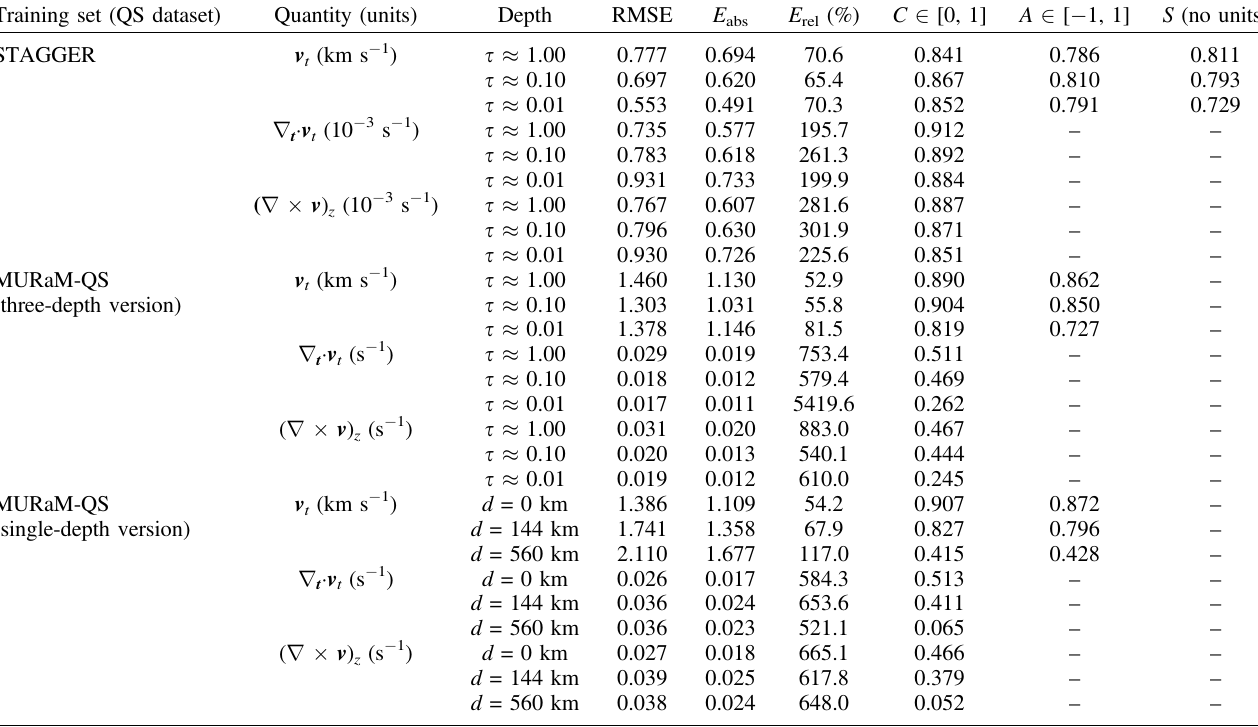
Table 2. Comparison between fl ow fi elds v D ,t and v ref, t for the QS datasets (i.e., STAGGER and MURaM-QS). RMSE is the root mean squared error (Eq. (1)), E abs is the mean absolute error (Eq. (2)), E rel is the mean relative error (Eq. (3)), C is the correlation coef fi cient (Eq. (4)), A is the spatially-averaged normalized dot product (Eq. (5)) and S is the ratio between the integrals of the unsigned shear components of the DeepVel and reference Poynting fl uxes (Eq.